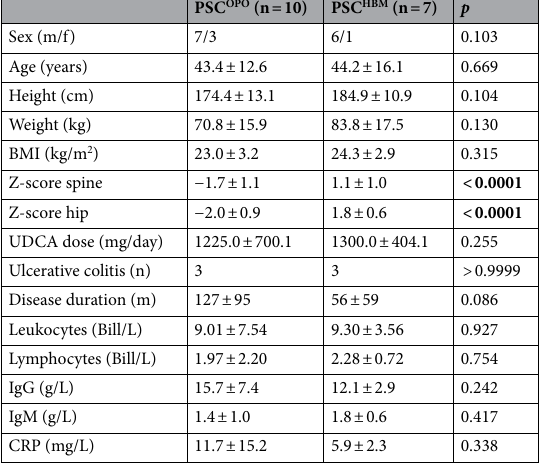
Table 1. Demographic and clinical characteristics of PSC OPO and PSC HBM patients. Significant values are in